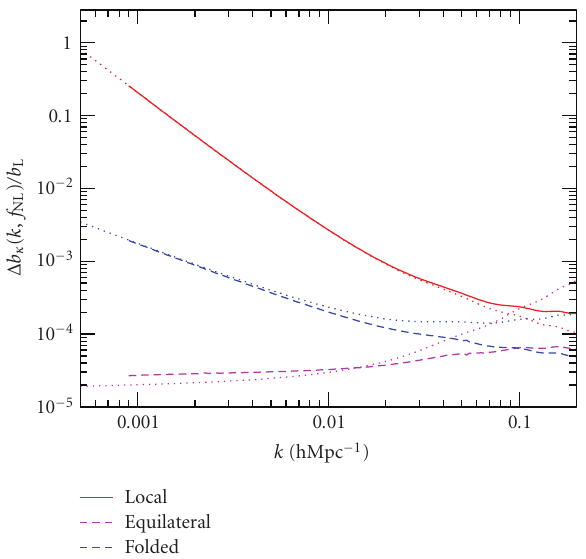
Figure 6: Non-Gaussian bias correction (33) for the local, equilateral and folded primordial bispectrum as a function of wavenumber. Results are shown at z = 0 for a smoothing radius R = 5h − 1 Mpc and a nonlinear parameter f X NL = 1. The dotted line represent an analytic approximation, (35), which is valid at large- ) does scales k (cid:2) 1. Note that while the magnitude of Δ b κ ( k , f loc NL ) and Δ b κ ( k , f fol ) strongly depends on not change with R , Δ b κ ( k , f eq NL NL the smoothing radius (see